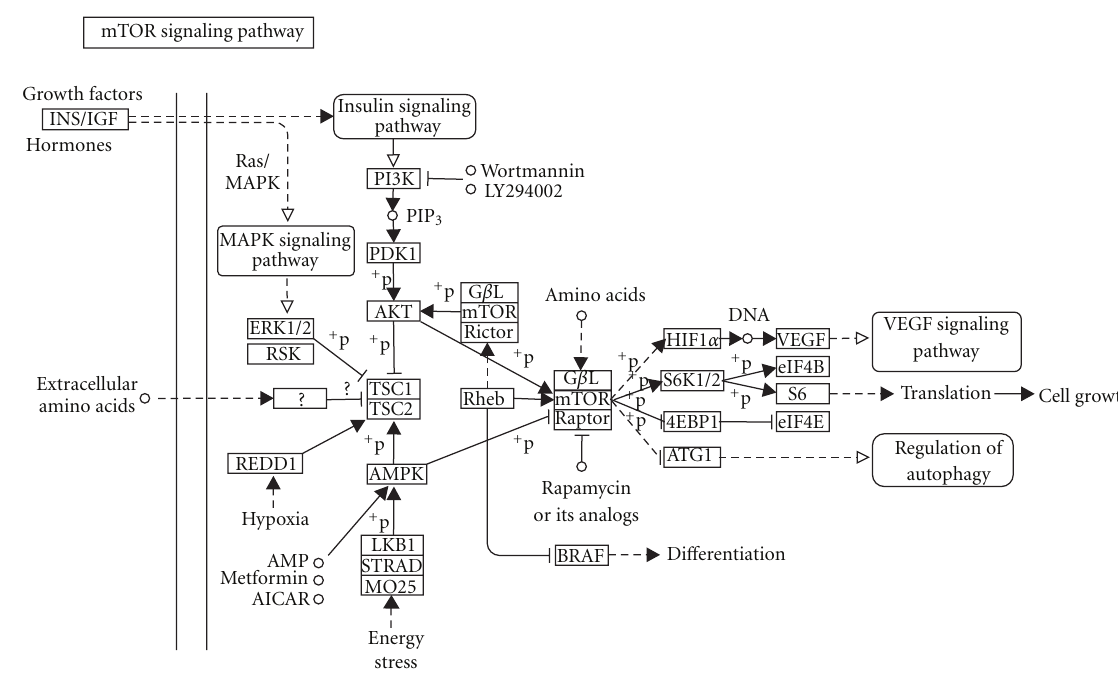
Figure 9: mTOR signaling pathway extracted from KEGG database